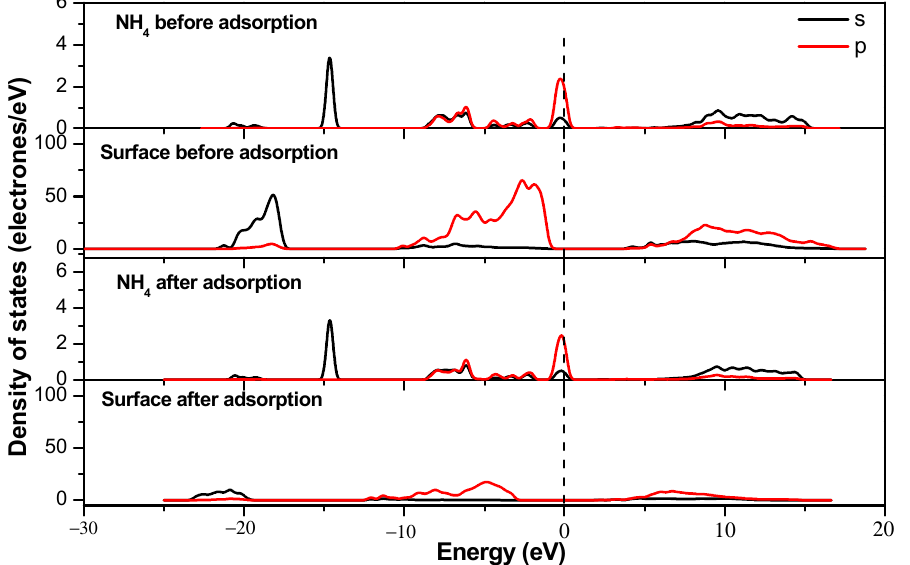
Figure 8. PDOS of NH 4 and (001) surface of Mt before and after adsorption.